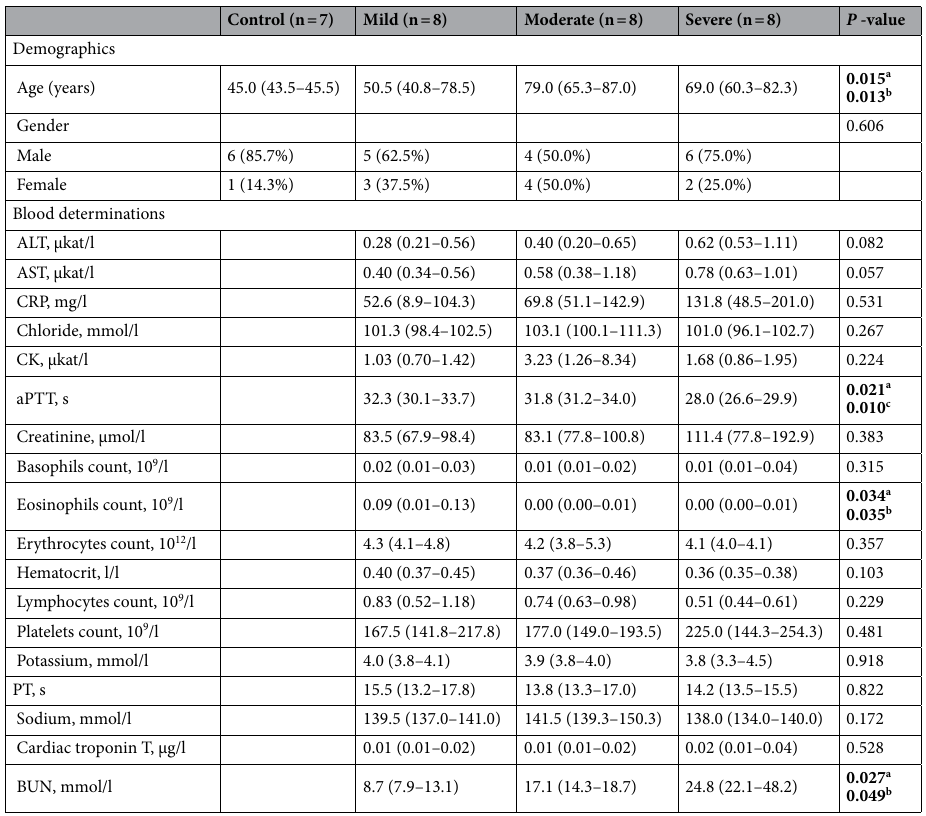
Table 1. Patient demographics and haematological and biochemical variables. Patients’ data were compared using Fisher’s exact test for categorical variables. Kruskal–Wallis test was used for continuous variables, if p < 0.05, the U de Mann–Whitney test was applied. Significant differences are reported in these cases. Continuous variables are given as medians and interquartile ranges (25th–75th percentile) and categorical ones by the number of patients and percentage, n (%). The Mann–Whitney U test was applied between ( a ) severe and mild, ( b ) moderate and mild, and ( c ) severe and moderate groups. ALT, alanine